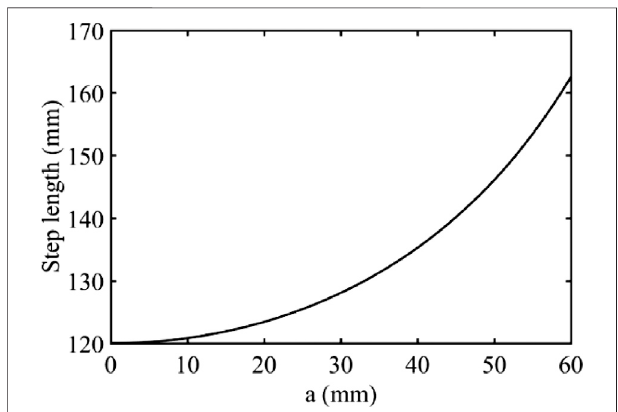
FIGURE 6 | Step length with respect to the slider guide